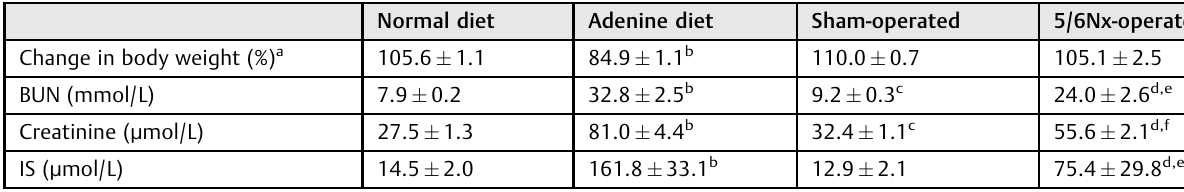
Abbreviations: BUN, blood urea nitrogen; IS, indoxyl sulfate; SEM, standard error of the mean. a Compared with initial body weight at the beginning of protocols. Note: Data are expressed as mean (cid:3) SEM ( n ¼ 8/group). b p < 0.001 versus normal-diet group; c p < 0.05; d p < 0.001 versus sham-operated group; d p <